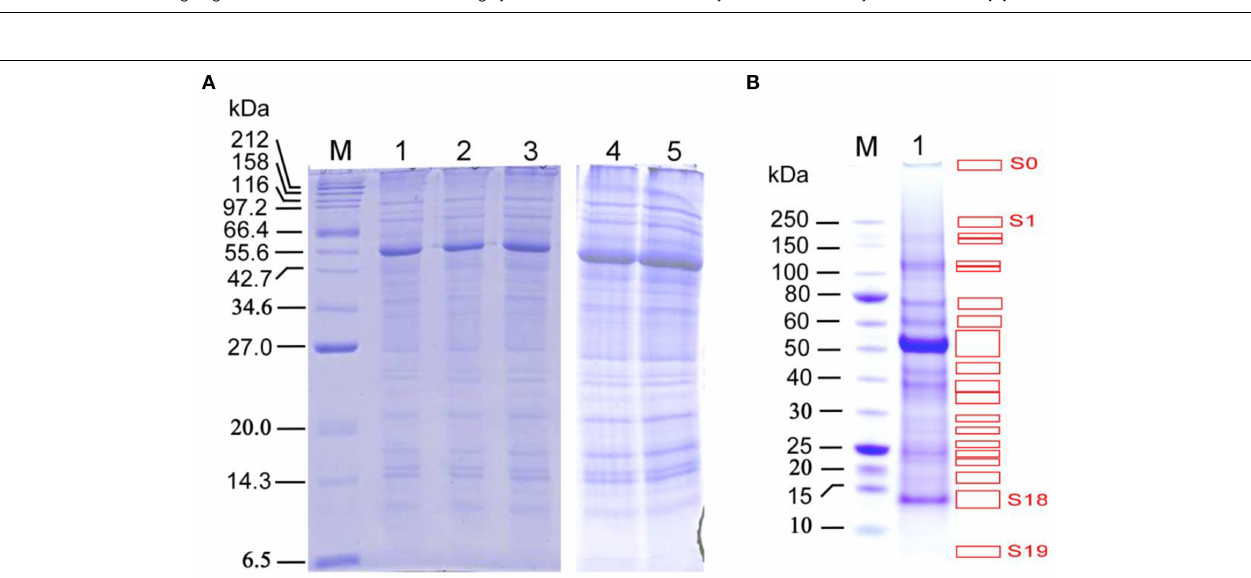
FIGURE 1 | The Arabidopsis plants and the representative transmission electron micrograph (TEM) of cells in the late growth stage Arabidopsis stems. (A) The Arabidopsis plants used for CaCl 2 -extraction of plant stem cell walls at late growth stage (i.e., pods beginning to desiccate). (B) An enlarged image showing siliques turning color from green to yellow, an indicator that the plant is at the late stage of growth. (C) TEM image for sclerenchyma cells of a vascular bundle undergoing senescence. Cell I retains a largely intact